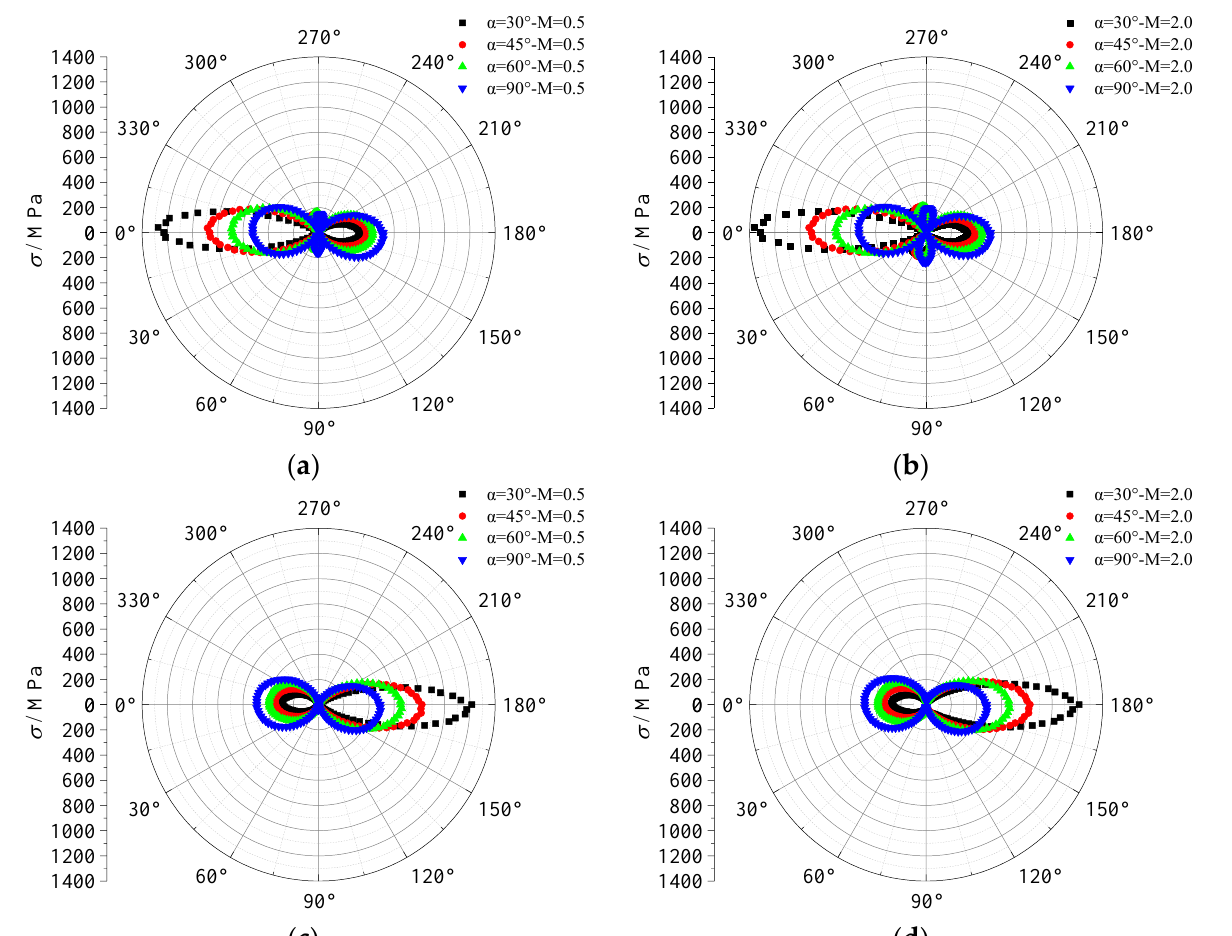
Figure 22. Thermal stress near the research film hole: ( a ) outlet at M = 0.5; ( b ) inlet at M = 2.0; ( c ) outlet at M = 0.5; ( d ) inlet at M = 2.0. ( a ) film hole outlet t at M = 0.5. ( b ) film hole outlet t at M = 2.0. ( c ) film hole inlet at M = 0.5. ( d ) film hole inlet at M = 2.0. Compared with the thermal stress distribution on the film plate and near the